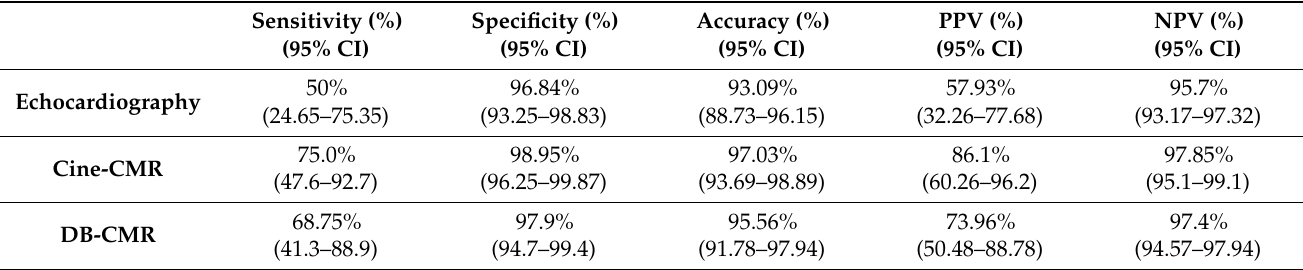
Table 3. Diagnostic performance of different techniques for detecting LV